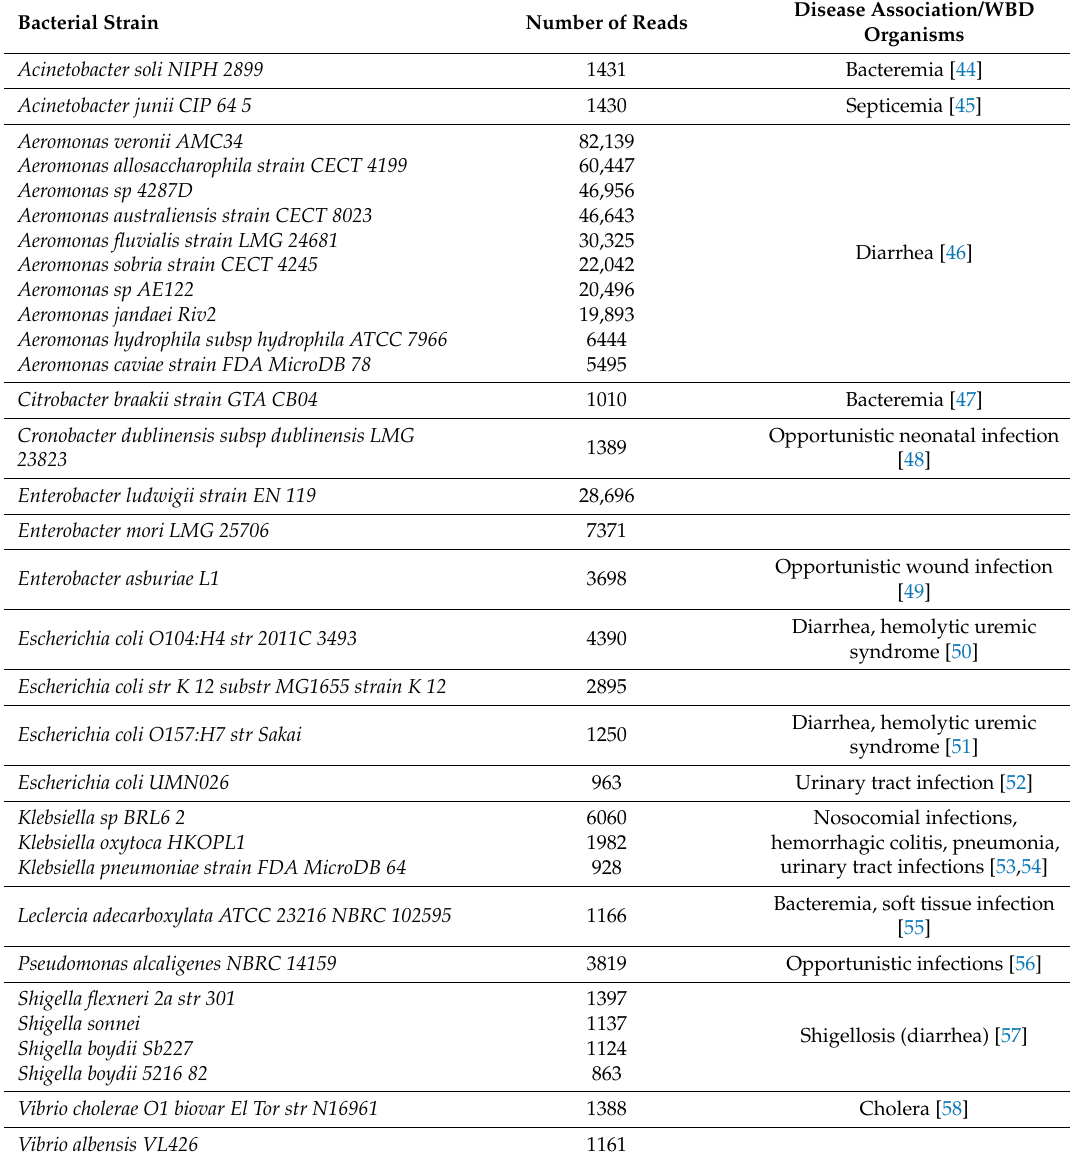
Table 4. Bacterial species identified by metagenomic analysis of DNA prepared after selective growth on m-ColiBlue24